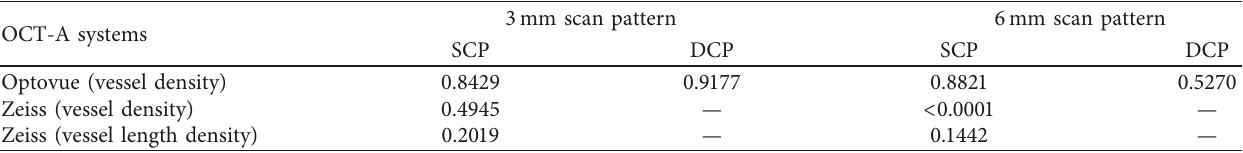
Table 3: P values for comparison of the intraclass correlation coefficients of the vascular density and vascular length density measurements derived with the built-in software of the optical coherence tomography angiography systems and third-party software. 3mm scan pattern 6mm scan pattern OCT-A systems SCP DCP SCP DCP Optovue (vessel density) 0.8429 0.5270 Zeiss (vessel density) 0.4945 — < 0.0001 Zeiss (vessel length density) 0.2019 —